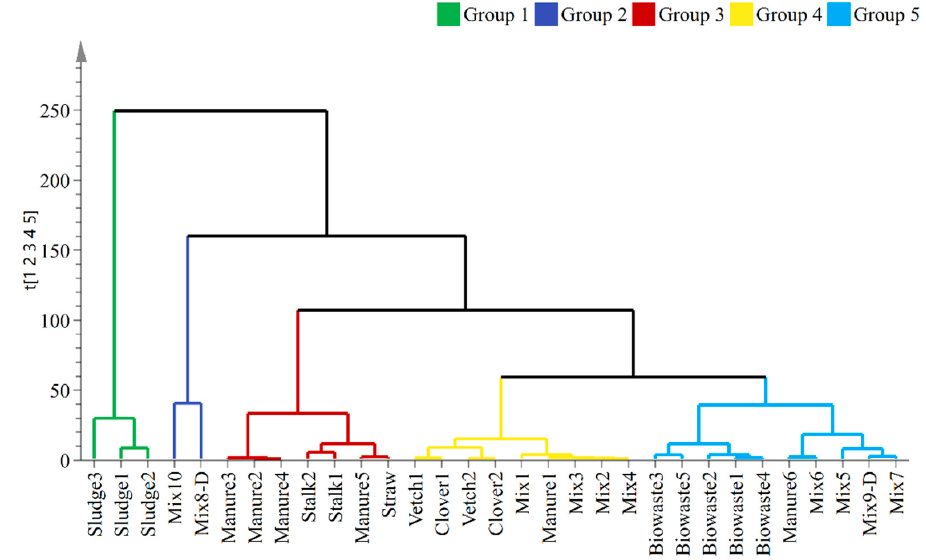
Figure 2. Hierarchical cluster analysis (HCA) of organic wastes.